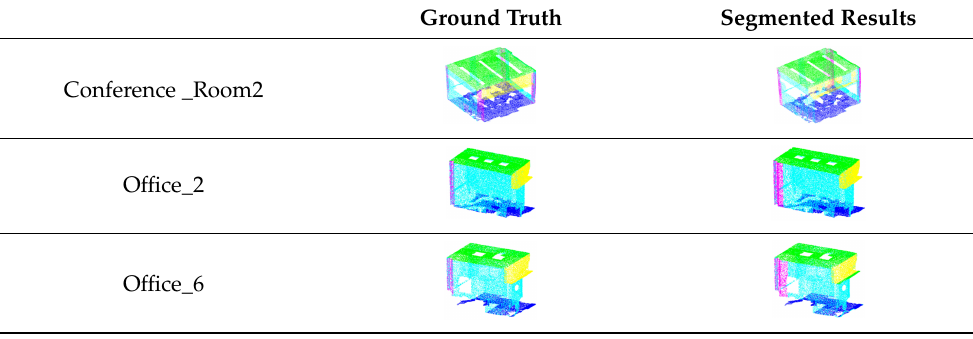
Table 4. Categories of ground truth and segmented results for S3DIS